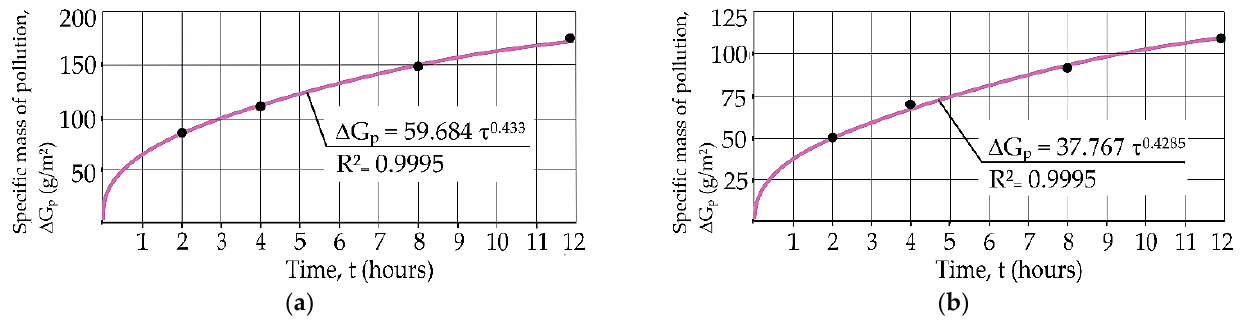
Figure 3. Dependences of the specific mass of pollution ∆ G p from time of experiments τ during fuel oil (S r = 1.5%, α = 2.9, and W r = 2%) ( a ) and WFE (S r = 1.5%, α = 2.9, and W r =30%) ( b ) combustion.